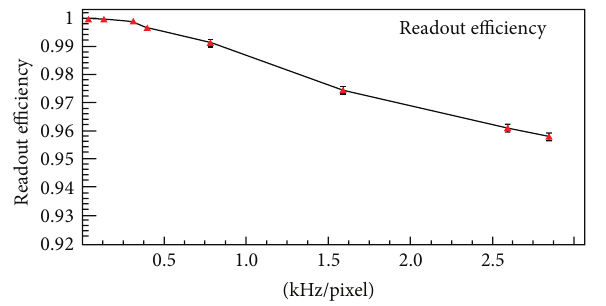
Figure 15: Efficiency versus hit rate (clk@40 MHz, Freezing- Time@5 𝜇 s).